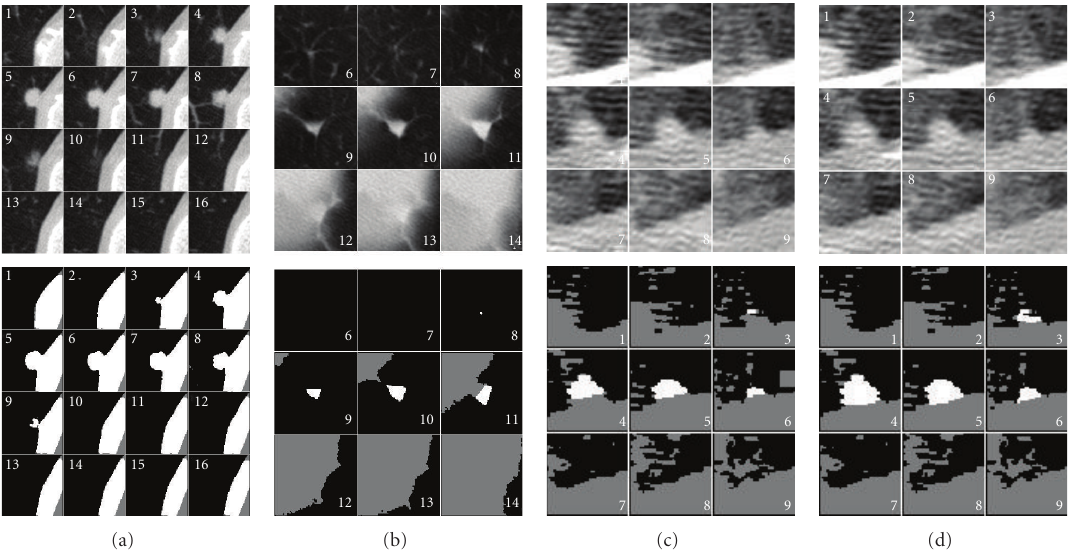
Figure 13: Examples of nodule segmentation ratings, (a) the segmentation includes extensive nonnodule regions, (b) the segmentation does not include the entire nodule, (c) the segmentation stops slightly short of the wall, and (d) the segmentation includes all of the nodule but none of the wall. Segmentations with a rating of 3 or 4 were considered acceptable. The top image shows the grayscale region of interest, while the bottom image shows the segmentation, with the nodule indicated in white and high-intensity nonnodule structures indicated by gray. Images were all windowed to enhance visibility and are not to scale.